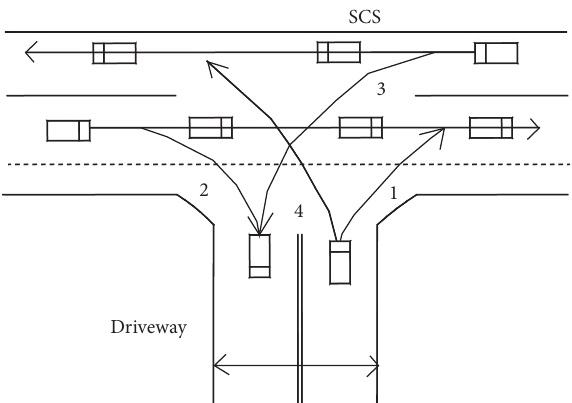
Figure 3: Typical movements between SCS and